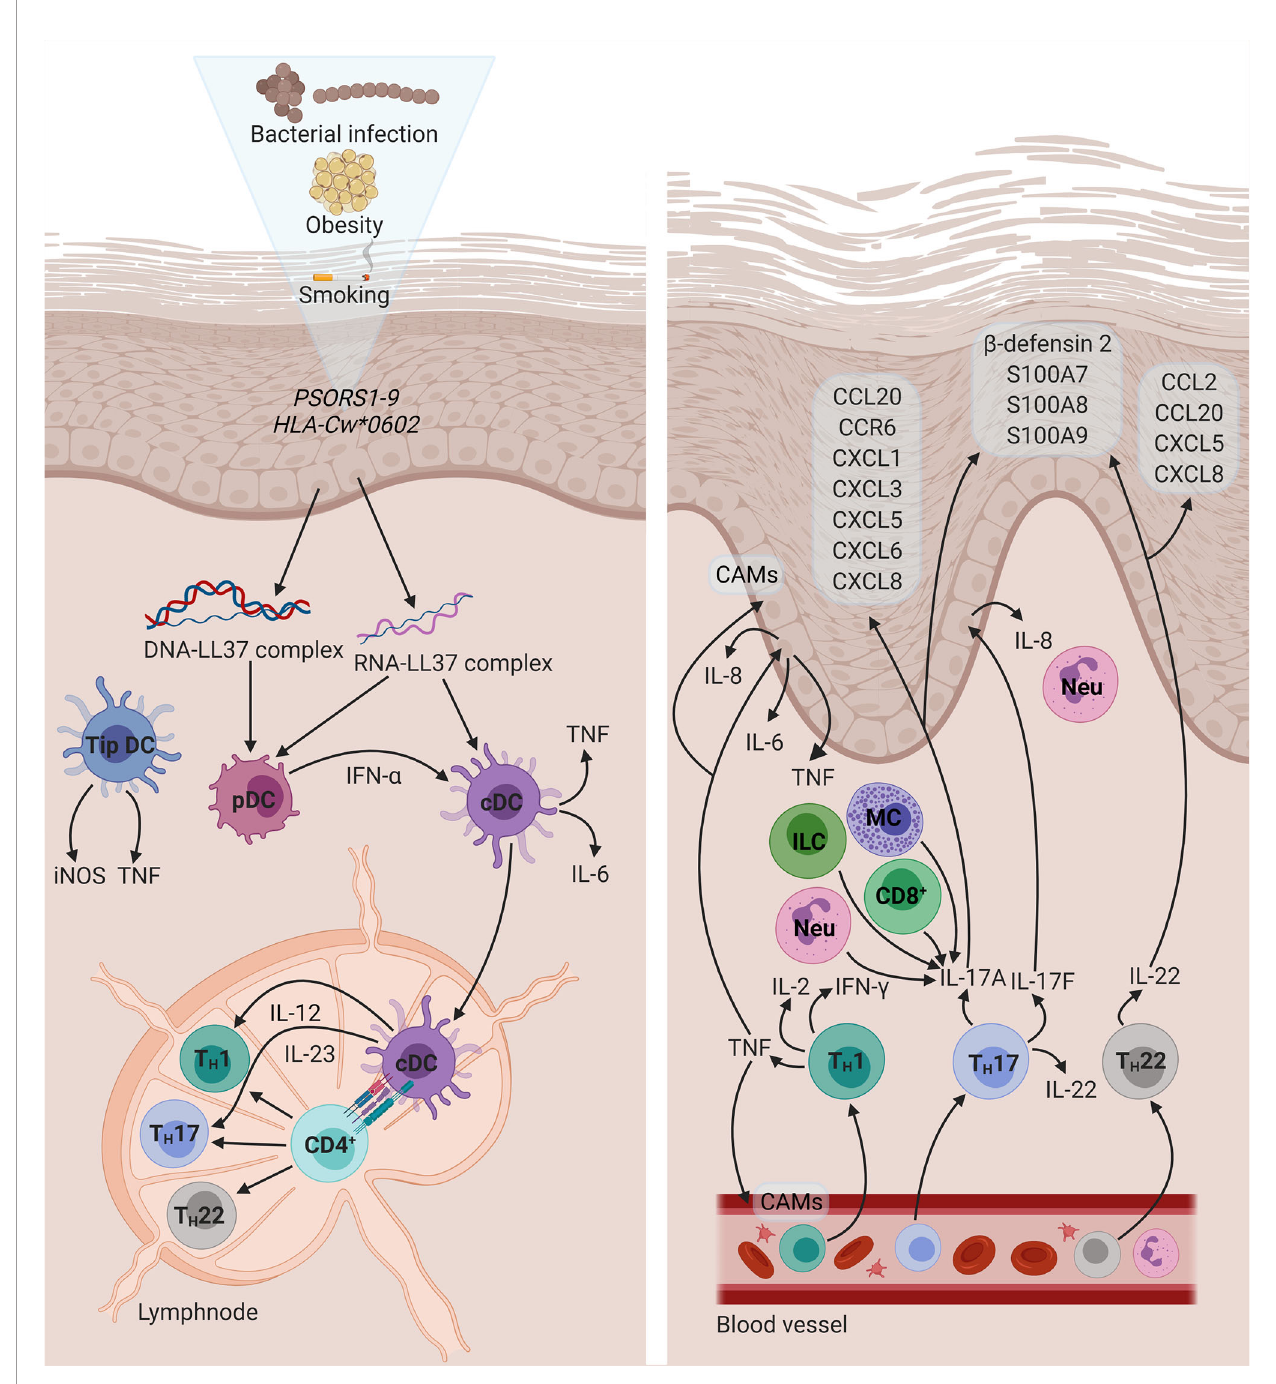
FIGURE 1 | The immunopathogenesis of PsO. A combination of genetic and environmental factors activates pDCs. In turn, cDCs activate naïve CD 4 + T cells through the presentation of an unknown antigen. Subsequently, activated CD4 + T cells differentiate into T H 1, T H 17, and T H 22 cells, which migrate to the dermis and give rise to a psoriatic plaque. Diagram created with BioRender.com. CAM, cell adhesion molecule; CCL, C-C motif chemokine ligand; CCR, C-C motif chemokine receptor; CD, cluster of differentiation; cDC, conventional dendritic cell; CXCL, C-X-C motif chemokine ligand; DNA, deoxyribonucleic acid; HLA , human leukocyte antigen; IFN, interferon; IL, interleukin; ILC, innate lymphoid cell; iNOS, inducible nitric oxide synthase; MC, mast cell; Neu, neutrophil; pDC, plasmacytoid dendritic cell; PSORS : psoriasis susceptibility; RNA, ribonucleic acid; S100, S100 calcium-binding protein; T H , T helper; Tip DC, tumour necrosis factor- and inducible nitric oxide synthase-producing dendritic cell; TNF, tumour necrosis